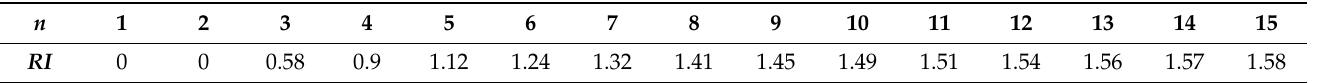
Table 3. Determination of RI according to Saaty